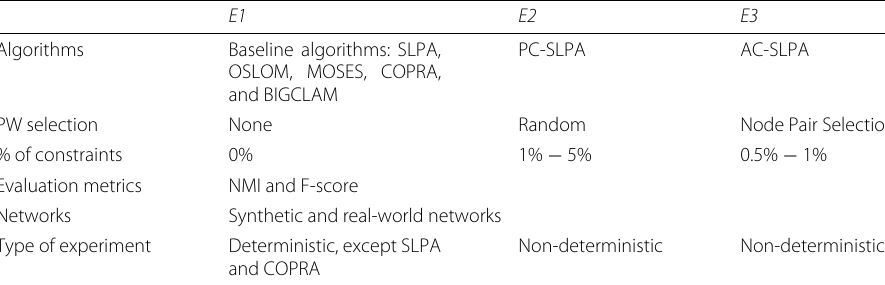
E1 E2 E3 Algorithms Baseline algorithms: SLPA, PC-SLPA AC-SLPA OSLOM, MOSES, COPRA, and BIGCLAM PW selection None Random Evaluation metrics NMI and F-score Networks Synthetic and real-world networks Type of experiment Deterministic, except SLPA Non-deterministic and COPRA